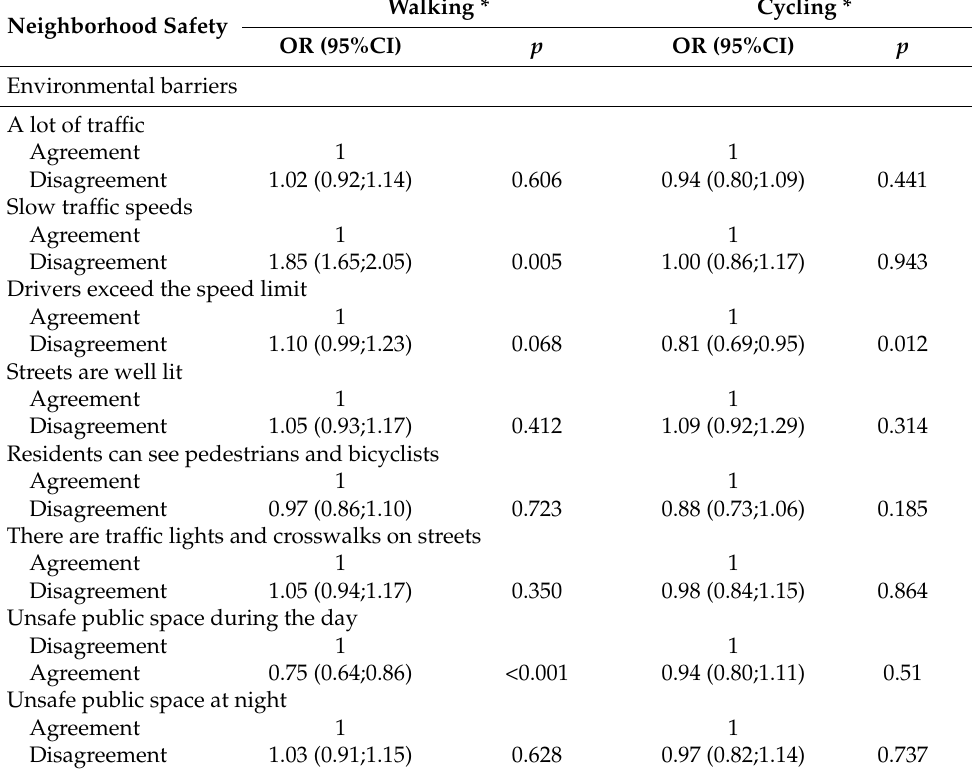
Table 4. Association (OR; 95%CI) between perceived neighborhood safety and active transportation (0 = <10 min/week, 1 = ≥ 10